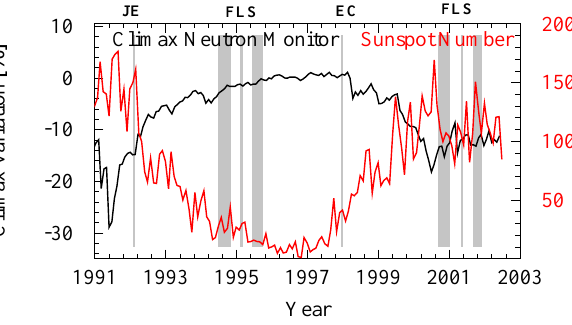
Fig. 2. Bartels rotation averaged time profile of > 3 GV particles as measured by the Climax neutron monitor (http://ulysses.uchicago. edu/NeutronMonitor/neutron \ mon.html) and monthly averaged sunspot number. The special periods as summarized in Table 1 are marked by